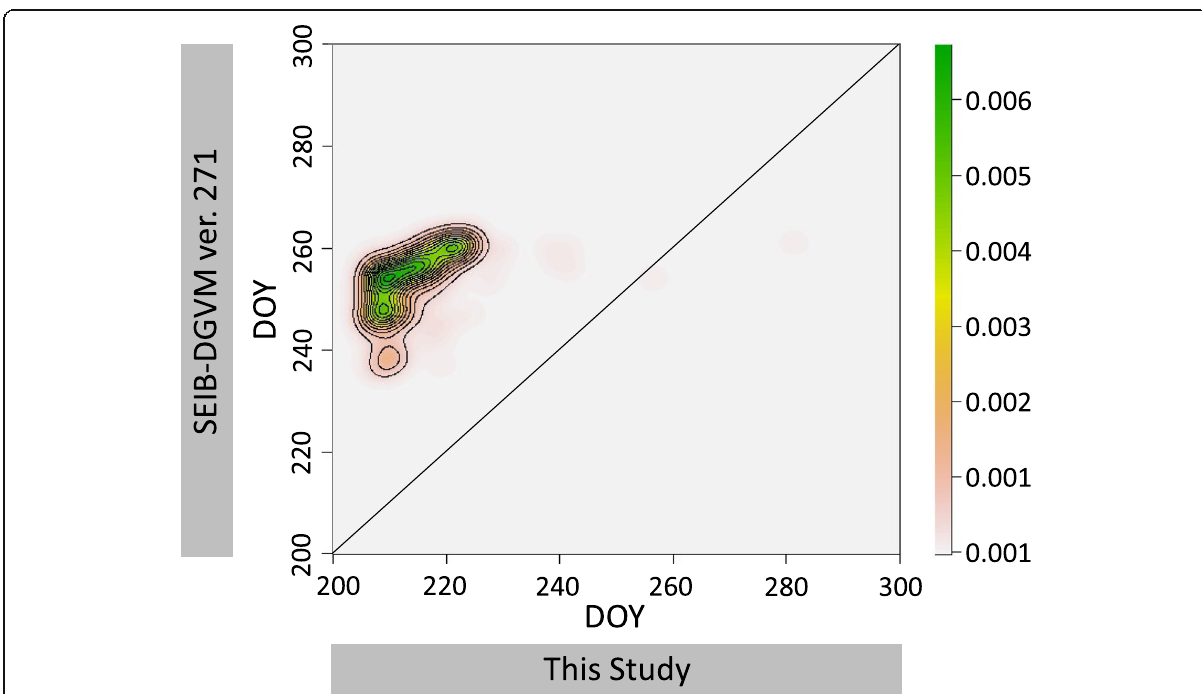
Fig. 7 Kernel density of the scatter plot of estimates of defoliation start date (DSD) for overstory. The plot shows DSD obtained in this study with data assimilation (TEST) against the original SEIB-DGVM